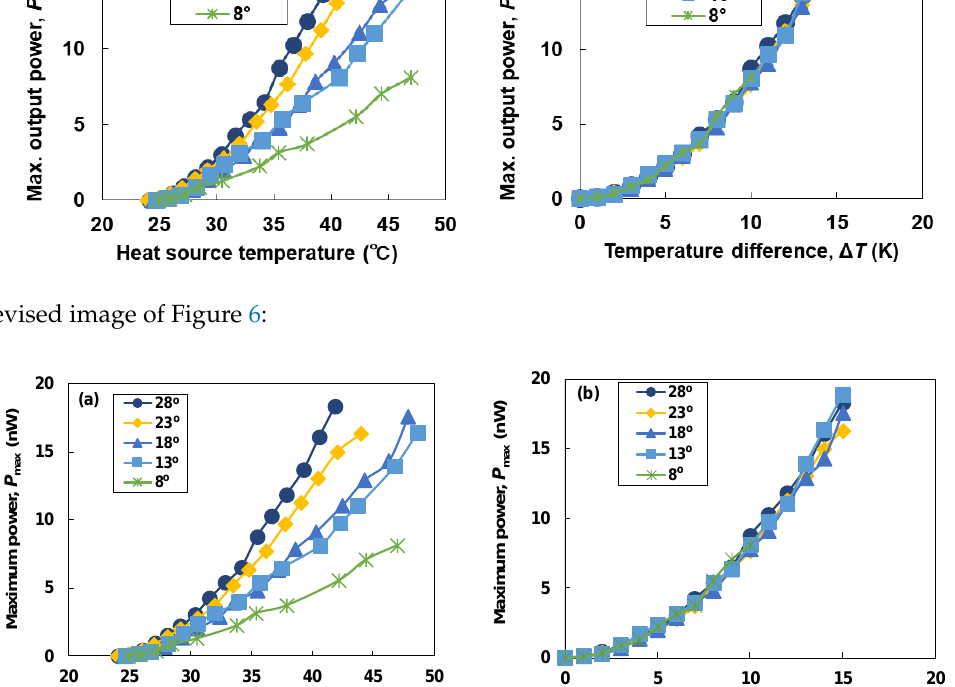
Coatings 2019 , 9 , 661; doi:10.3390 /